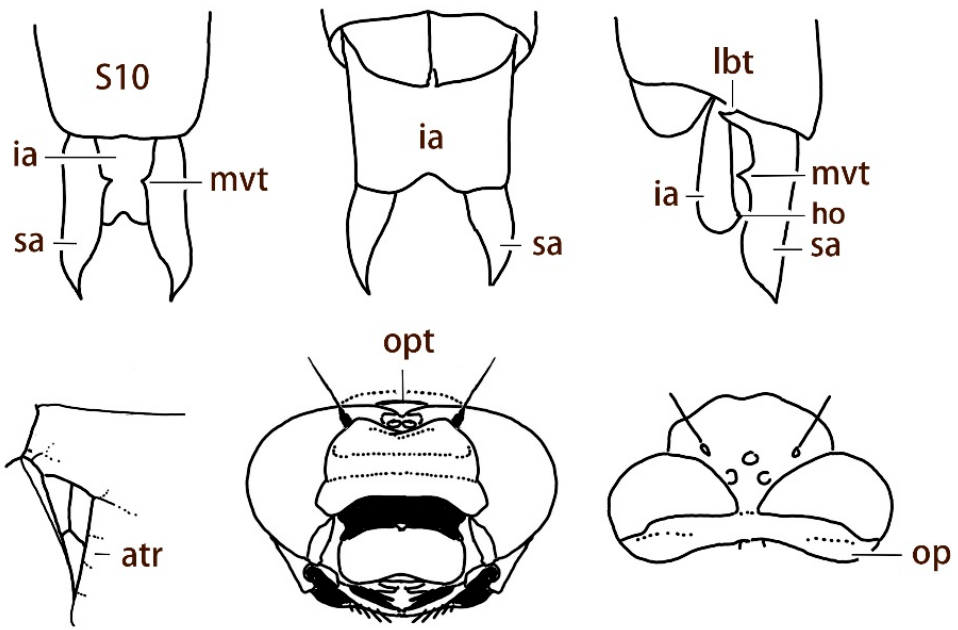
Figure 3. Main morphological characters of Codulegaster used for description and in the key. Abbreviations: ia—inferior appendage, sa—superior appendage, mvt—medioventral tooth, lbt— laterobasal tooth, ho—hook, op—occiput, opt—occipital triangle, atr—anal triangle, S10—abdominal segment 10.